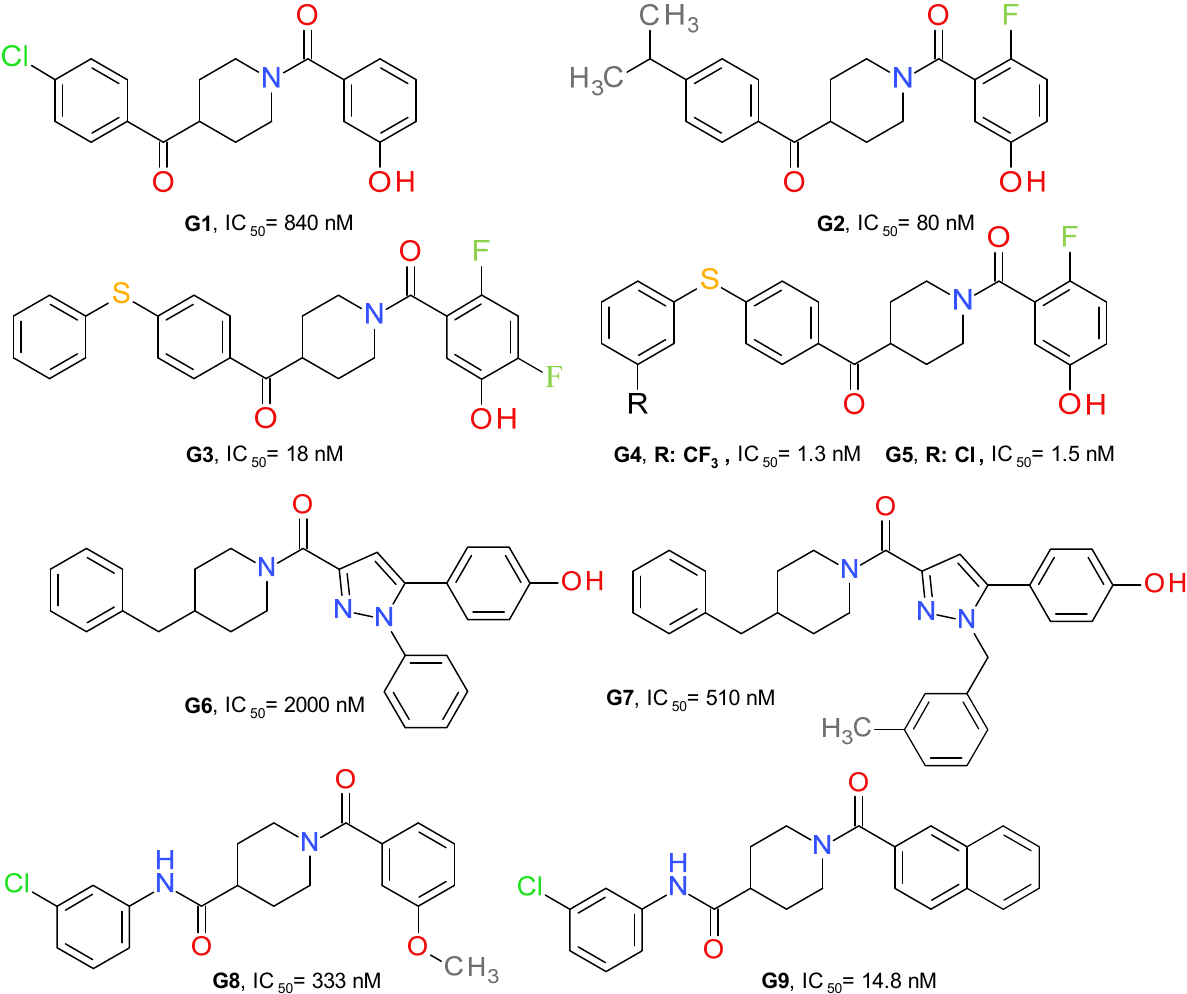
Figure 9. Reversible MAGL inhibitors—piperidine derivatives.